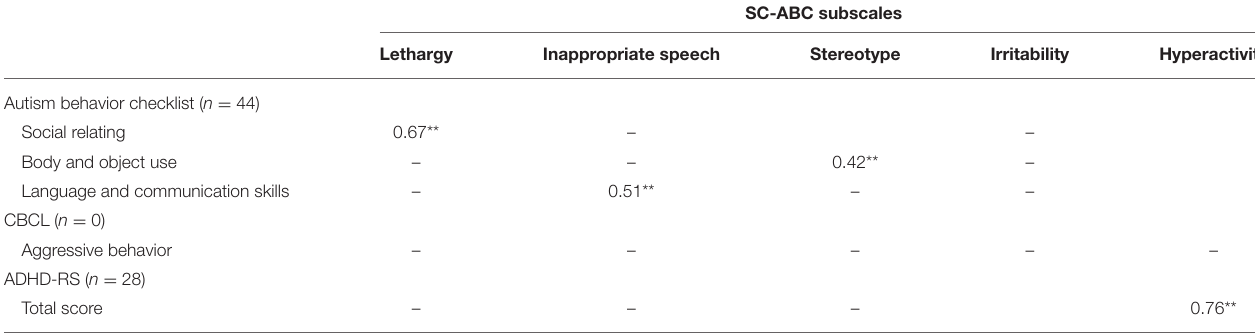
TABLE 6 | Spearman’s rank correlation coefficients for validity (age > 18).